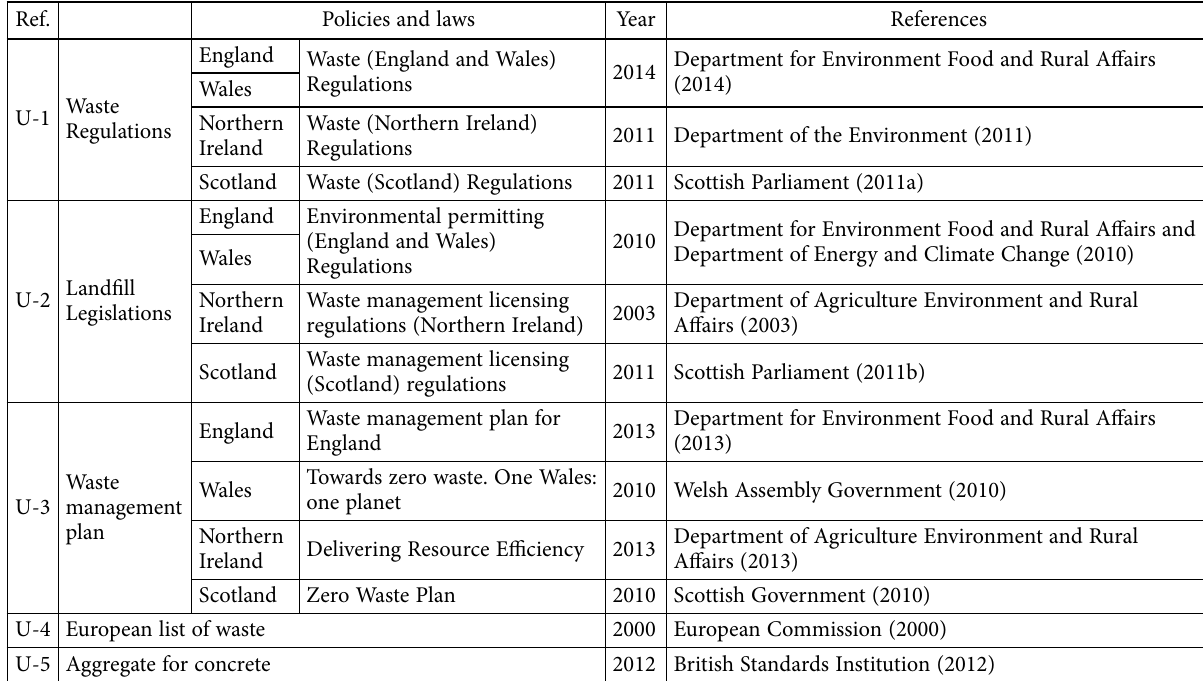
Table 9. Existing policies and laws on C&D waste management in the United Kingdom